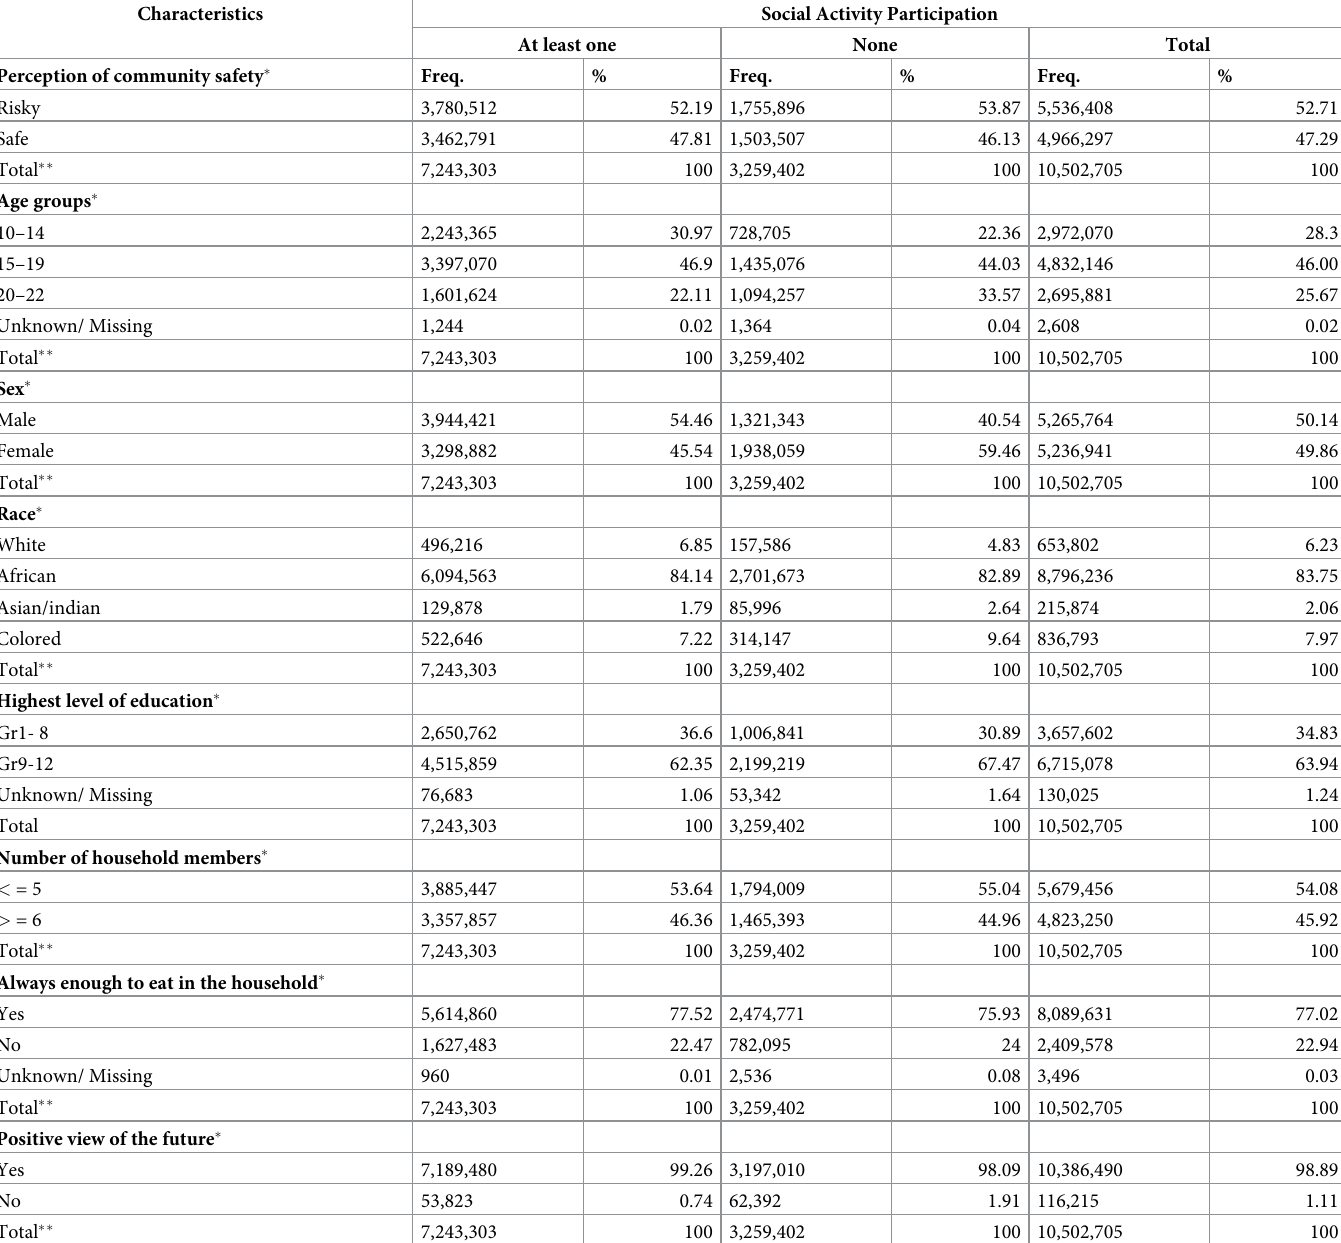
Table 2. Weighted characteristics of youth who participate in social activities in South Africa.